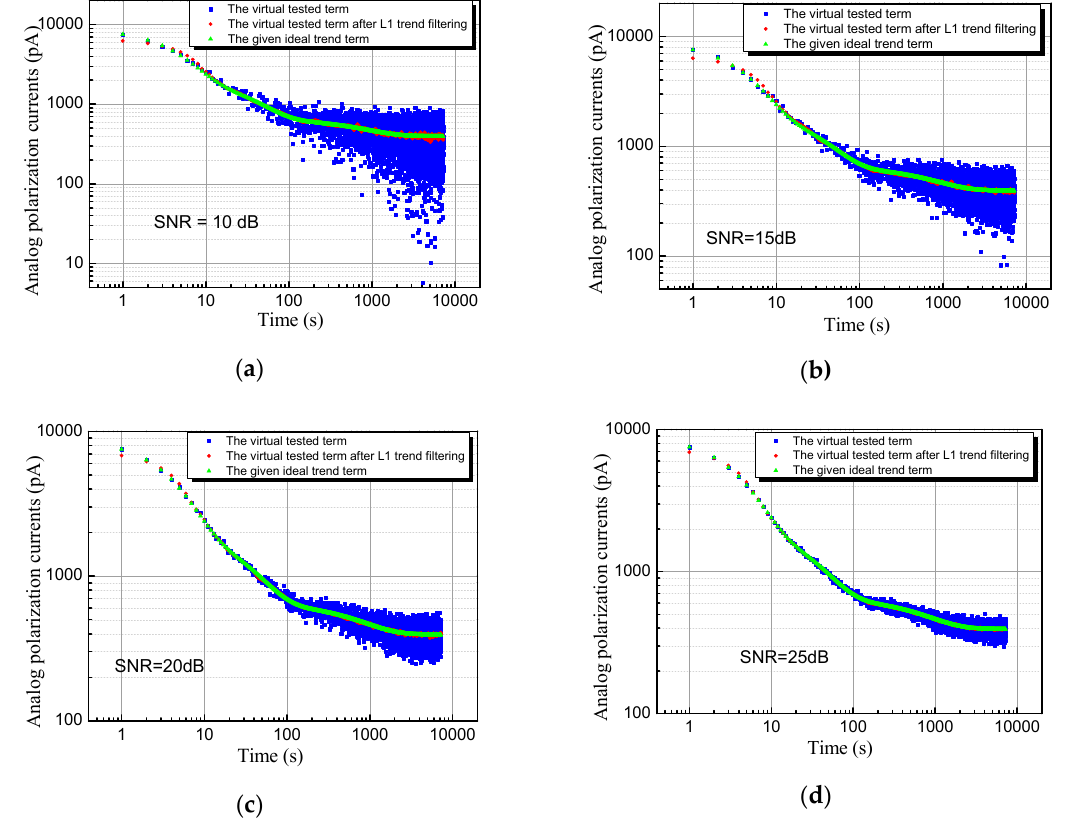
Figure 7. The effect diagram of L1 trend filtering for different degrees of noises with the ideal trend term produced by the extended Debye model: ( a ) SNR = 10 dB; ( b ) SNR = 15 dB; ( c ) SNR = 20 dB; ( d ) SNR = 25 dB.